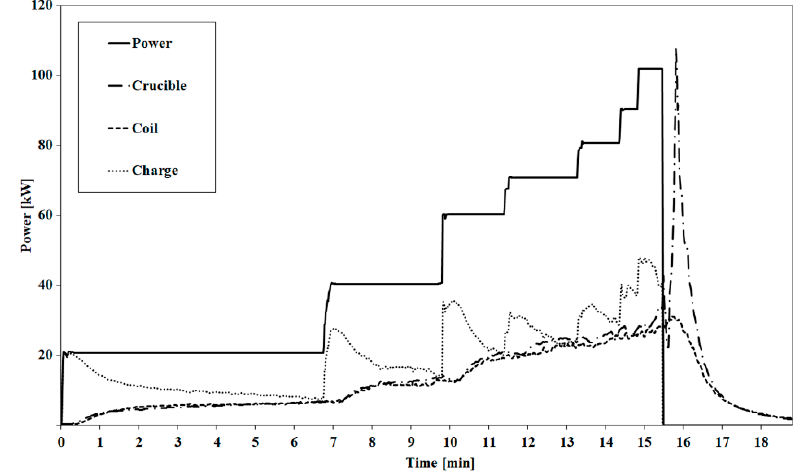
Figure 5. Second melting trial real-time power distribution.